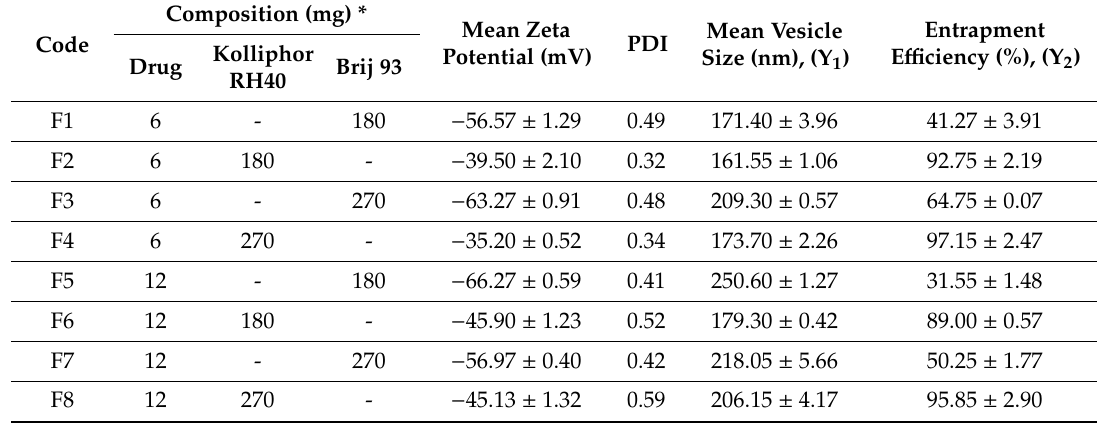
Table 1. Composition of curcumin proniosomes formulae and their characterization